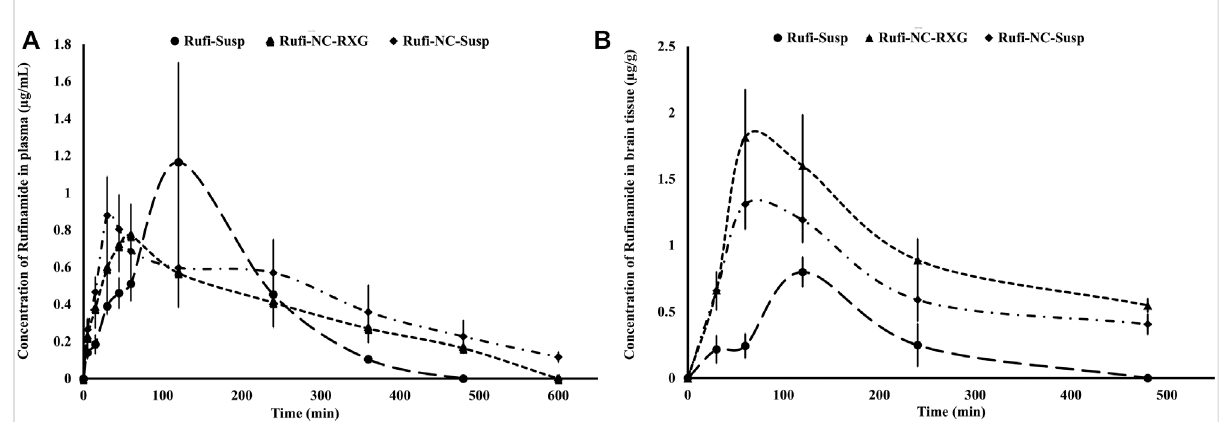
FIGURE 5 Plasma and brain pharmacokinetic performance of formulations. (A) : Mean concentration-time pro fi les of Ru fi obtained following intranasal administration of Ru fi -NC-Susp, Ru fi -NC-RXG, and Ru fi -Susp in plasma. (B) : Mean concentration-time pro fi les of Ru fi obtained following intranasal administration of Ru fi -NC-Susp, Ru fi -NC-RXG, and Ru fi -Susp in